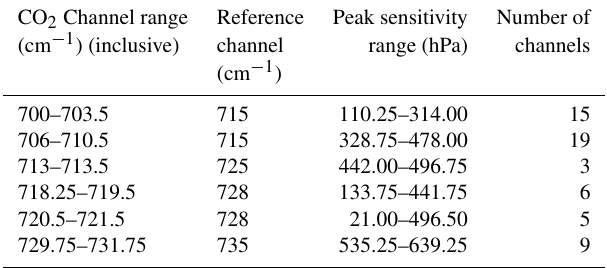
Table 3. The channel ranges selected for the final application of the CO 2 slicing technique. In total 57 channels are used. Following Arriaga (2007), 900.50cm − 1 is used as the window channel used to calculate the effective